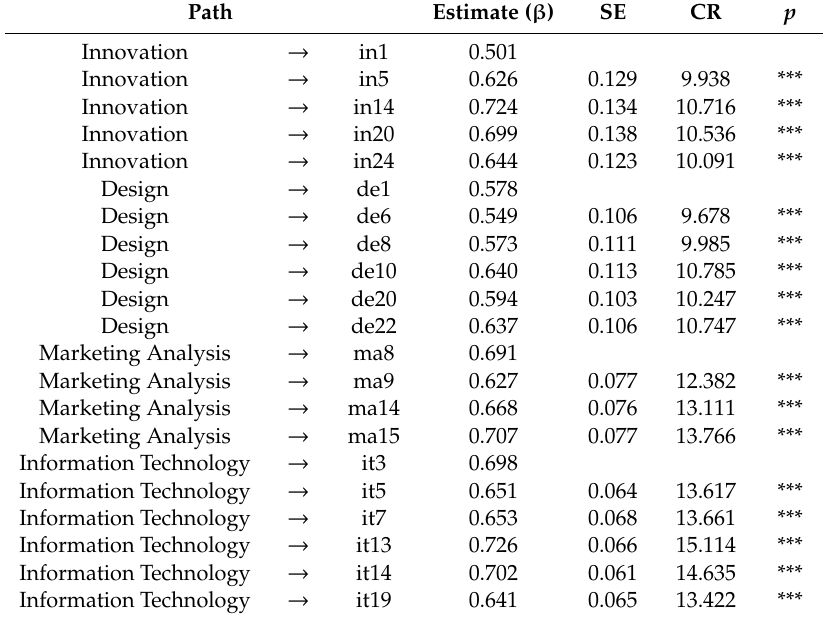
Table 4. The standardized regression weights and covariance estimates of the final refined structural equation